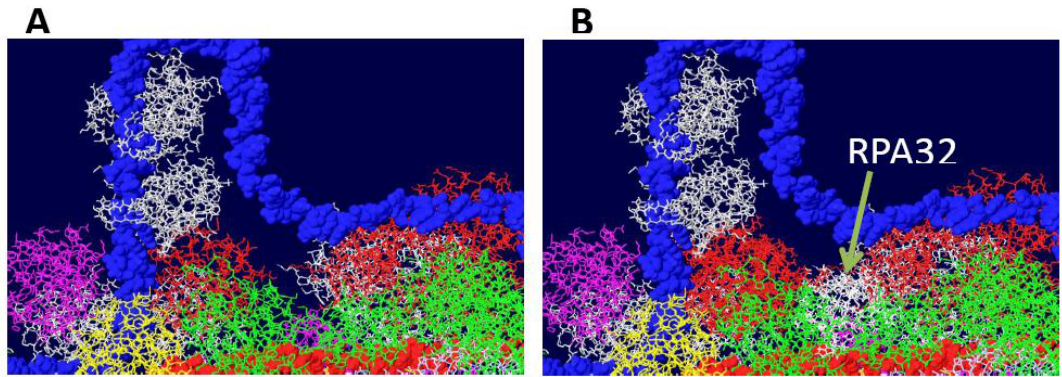
Figure S1. Fitting of the OBD:RPA32 structure on the DH. The OBD:RPA32 structure was fitted onto a DH by combining the OBD structure of the first with various OBD monomers of the second. A) image of DH surface and RPA70 before fitting. B) The red OBD monomer of the right hexamer was fitted with the OBD (also red) of the OBD:RPA32 costructure. The RPA32 molecule, shown in white, clashes with the helicase domain and is far removed from the RPA70 subunit.